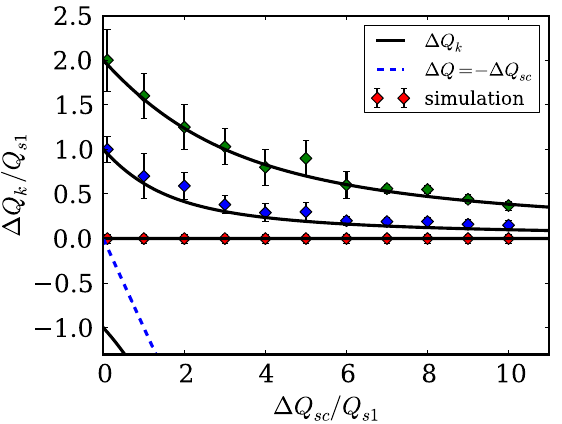
FIG. 2. Head-tail tune shifts and their width obtained from the simulations for q c ¼ 0 . The error bars indicate the width of the